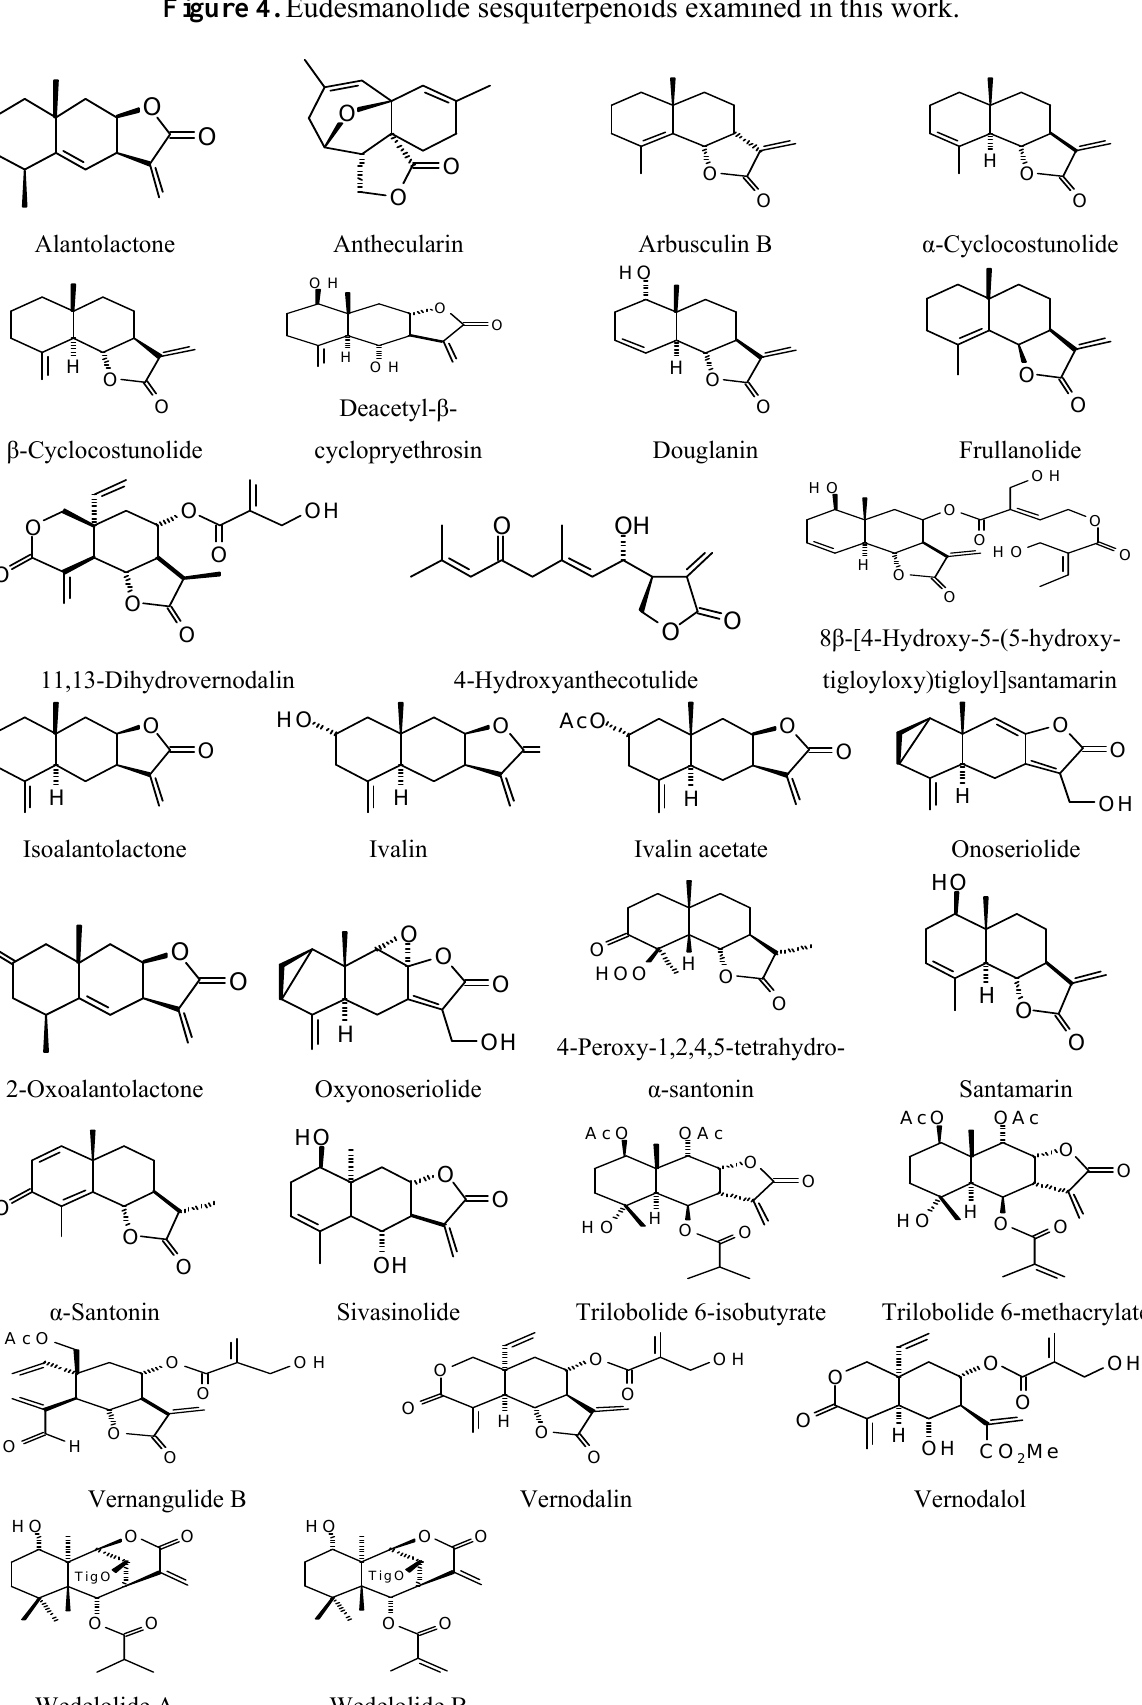
Figure 4. Eudesmanolide sesquiterpenoids examined in this